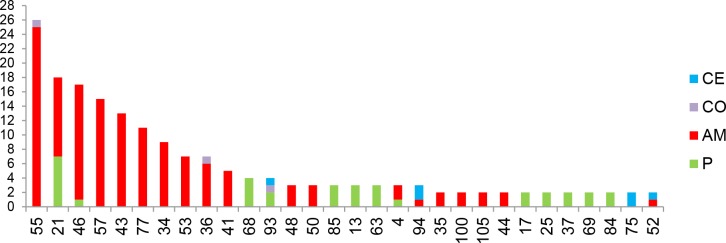
Repeated genotypes.Arbitrary numbers assigned to the 30 repeated genotypes in (x-axis) and number of isolates belonging to each genotype (y-axis). The origin of each isolates is indicated by the different colors.